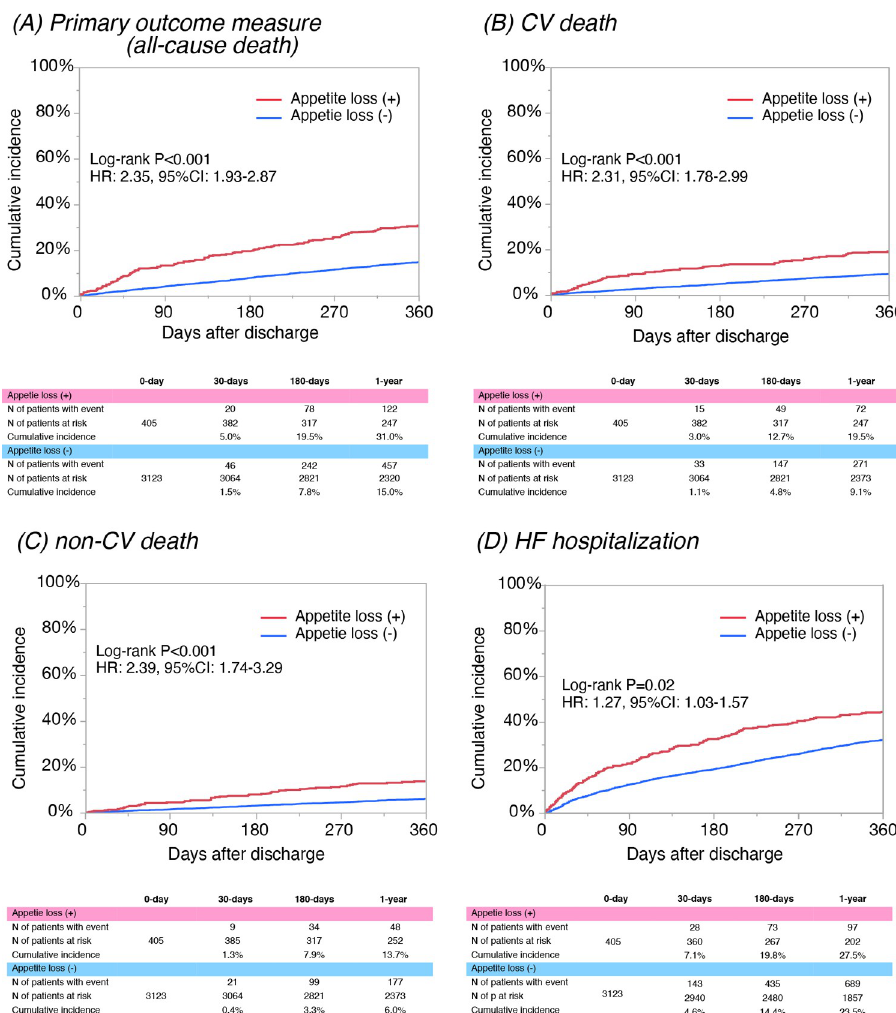
Fig 2. Kaplan-Meier curves according to the presence or absence of appetite loss at discharge for (A) the primary outcome measure (all-cause death), (B) CV death, (C) non-CV death, and (D) HF hospitalization. HR, hazard ratio; CI, confidence interval; CV, cardiovascular; HF, heart